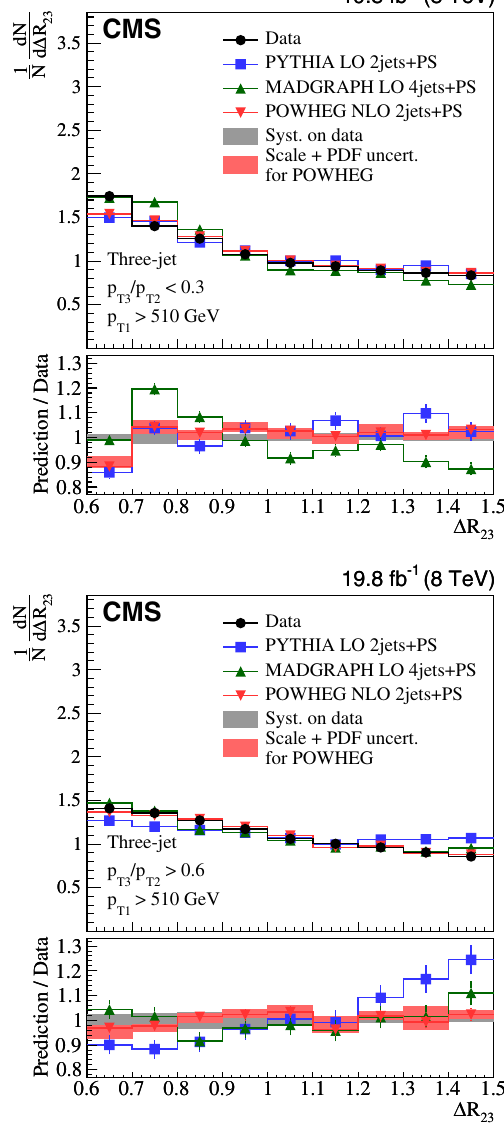
√ Fig. 3 Three-jet events at s = 8TeV and comparison to theoretical predictions: (upper) Δ R 23 for soft radiation ( p T3 / p T2 < 0 . 3), (lower) Δ R / p > 0 . 23 for hard radiation ( p T3 T2